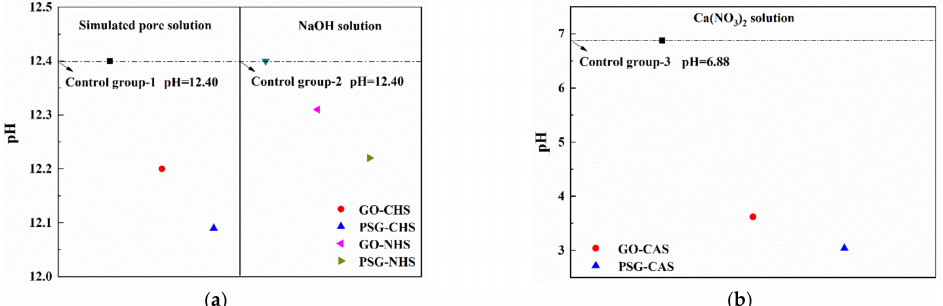
Figure 17. Effects of GO and PSG on pH in alkaline conditions and neutral conditions: ( a ) alkaline conditions; and ( b ) neutral